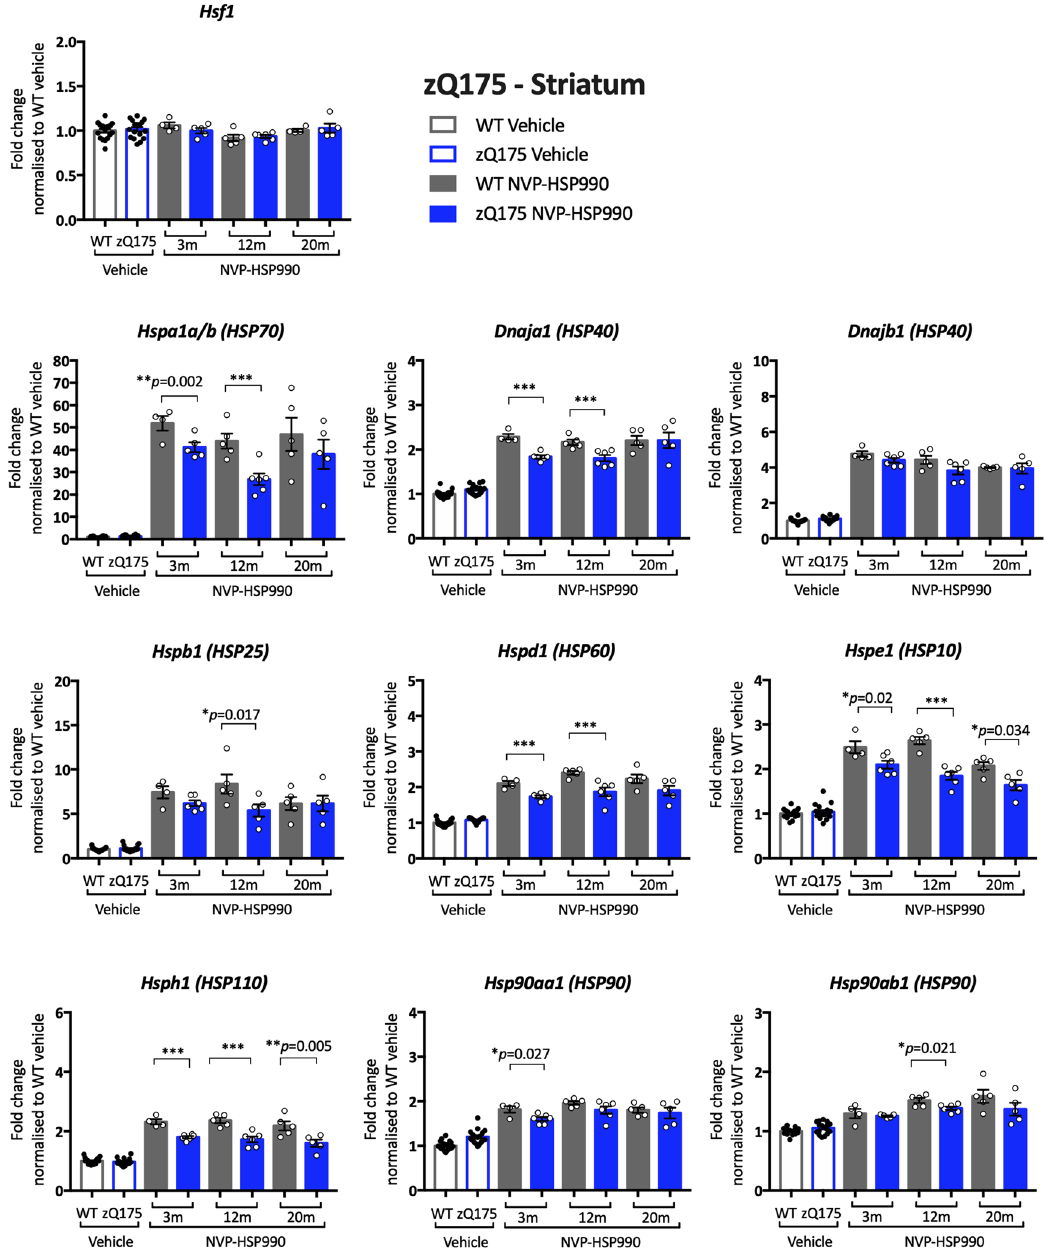
Figure 4. Analysis of the heat shock response in the striatum of zQ175 mice with disease progression. The expression of heat shock genes was measured using the QuantiGene 16-plex assay in the striatum of wild-type and zQ175 mice at 3, 12 and 20 months of age that had been treated with vehicle or NVP-HSP990. The NVP- HSP990 treated samples were normalised to the corresponding age-matched wild-type vehicle treated samples. For simplicity, the wild-type vehicle samples and the zQ175 vehicle samples from the three ages were combined. Five NVP-HSP990 treated samples were excluded from the analysis, because the tibialis anterior heat shock gene expression levels were comparable to those treated with vehicle. These were: at 3 months, two wild type; at 12 months, one wild type; at 20 months, one wild-type and one zQ175. N = 4–6/genotype/treatment/age. Statistical analysis was by two-way ANOVA with Bonferroni correction for multiple comparisons. Mean ± SEM. *** p ≤ 0.001. Test statistical values can be found in Supplementary Table S10 online. WT wild-type, m